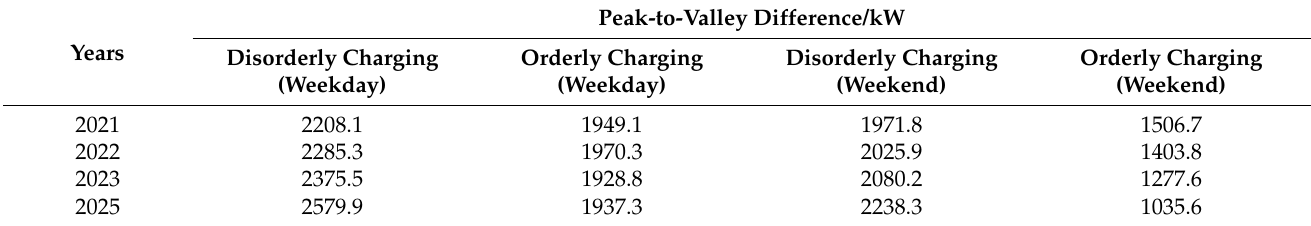
Table 3. Comparison of load peak-to-valley difference between orderly and disorderly charging.